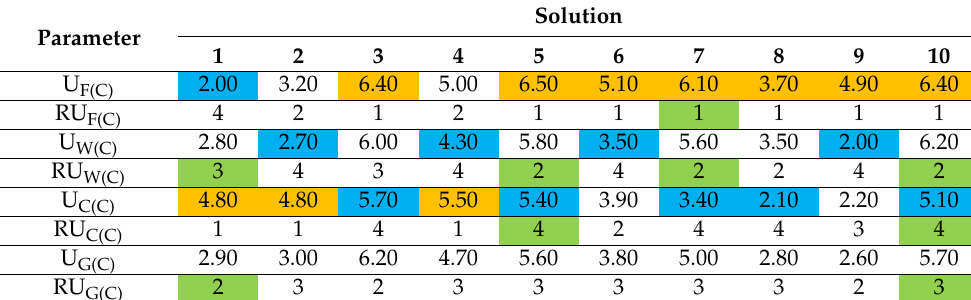
Table 8. Survey results and ranking of mean uniformity levels of computer image of corridor for each solution, in group C.